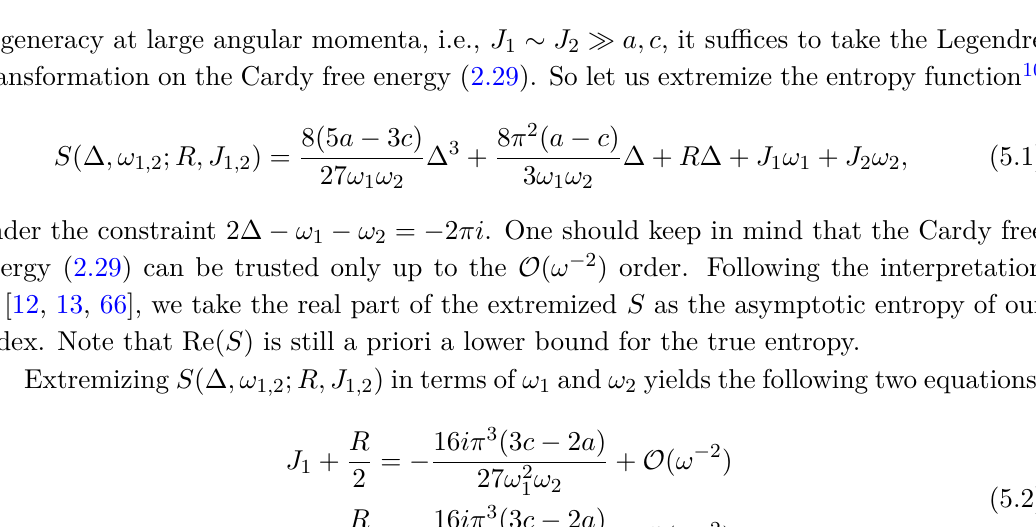
Figure 7. Im F| ∆= − iπ for the SU (2) 3 theories coupled via